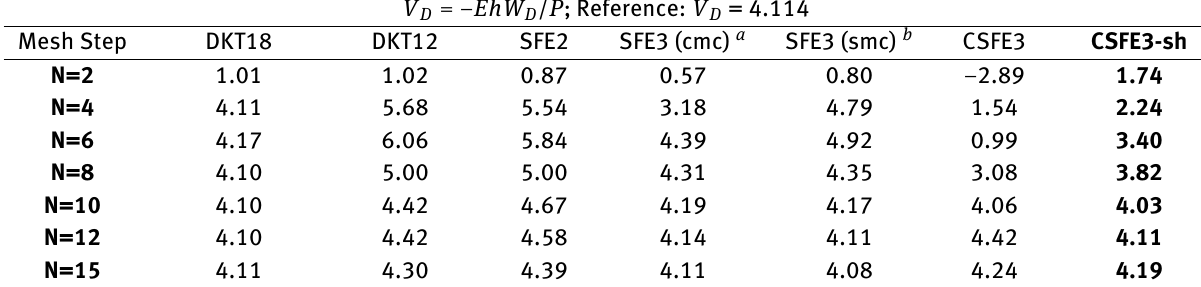
Table 4: Displacements results V D at point D